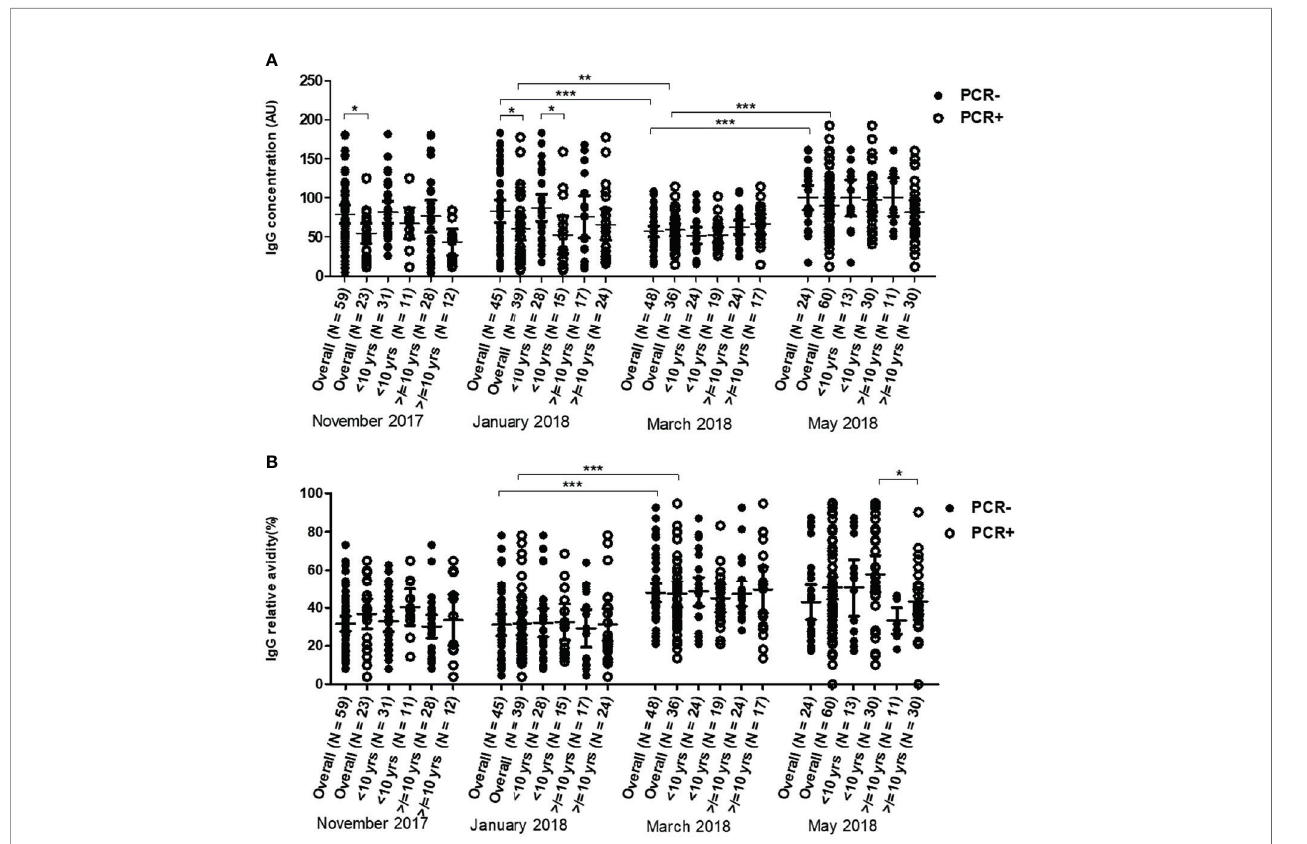
FIGURE 5 | Variations in of anti-Pfs48/45 IgG levels (A) and Relative avidities (B) in young children (<10 years) and older children ( ≥ 10 years) with (positive polymerase chain reaction test result) and without (negative-polymerase chain reaction test result) active P. falciparum infections over the dry season from November 2017 to May 2018. The number above each of the aligned dot plots represents the number of individuals in the group. The extent of statistically signi fi cant difference in measurements indicated by *, ** and *** represent P <0.05, P <0.01, and P <0.001